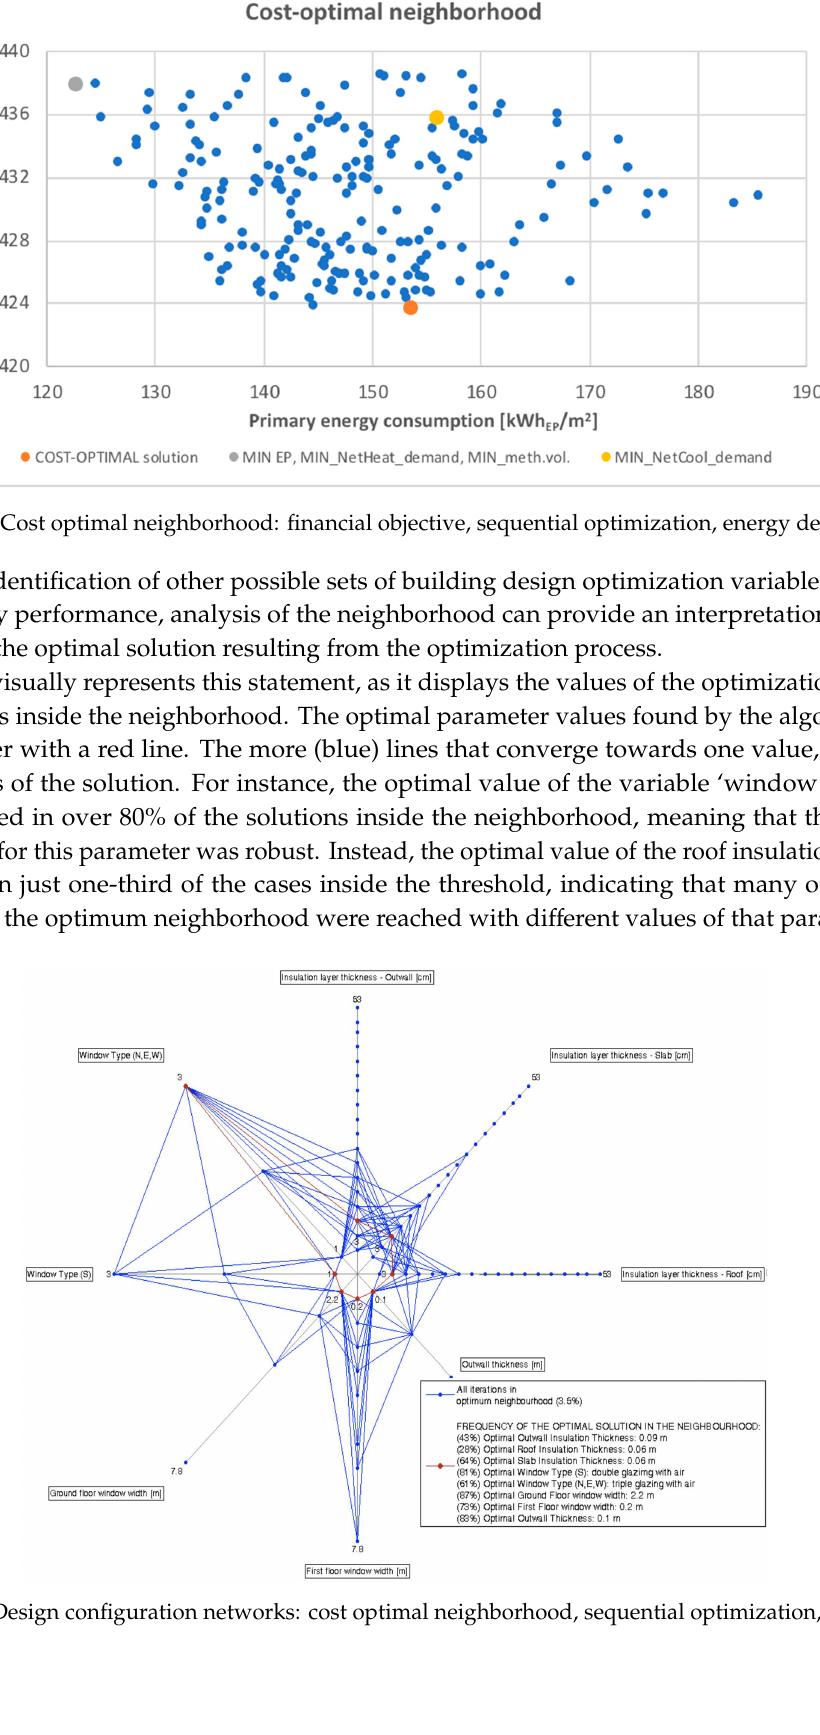
Figure 5. Design configuration networks: financial objective, sequential optimization, energy demand.